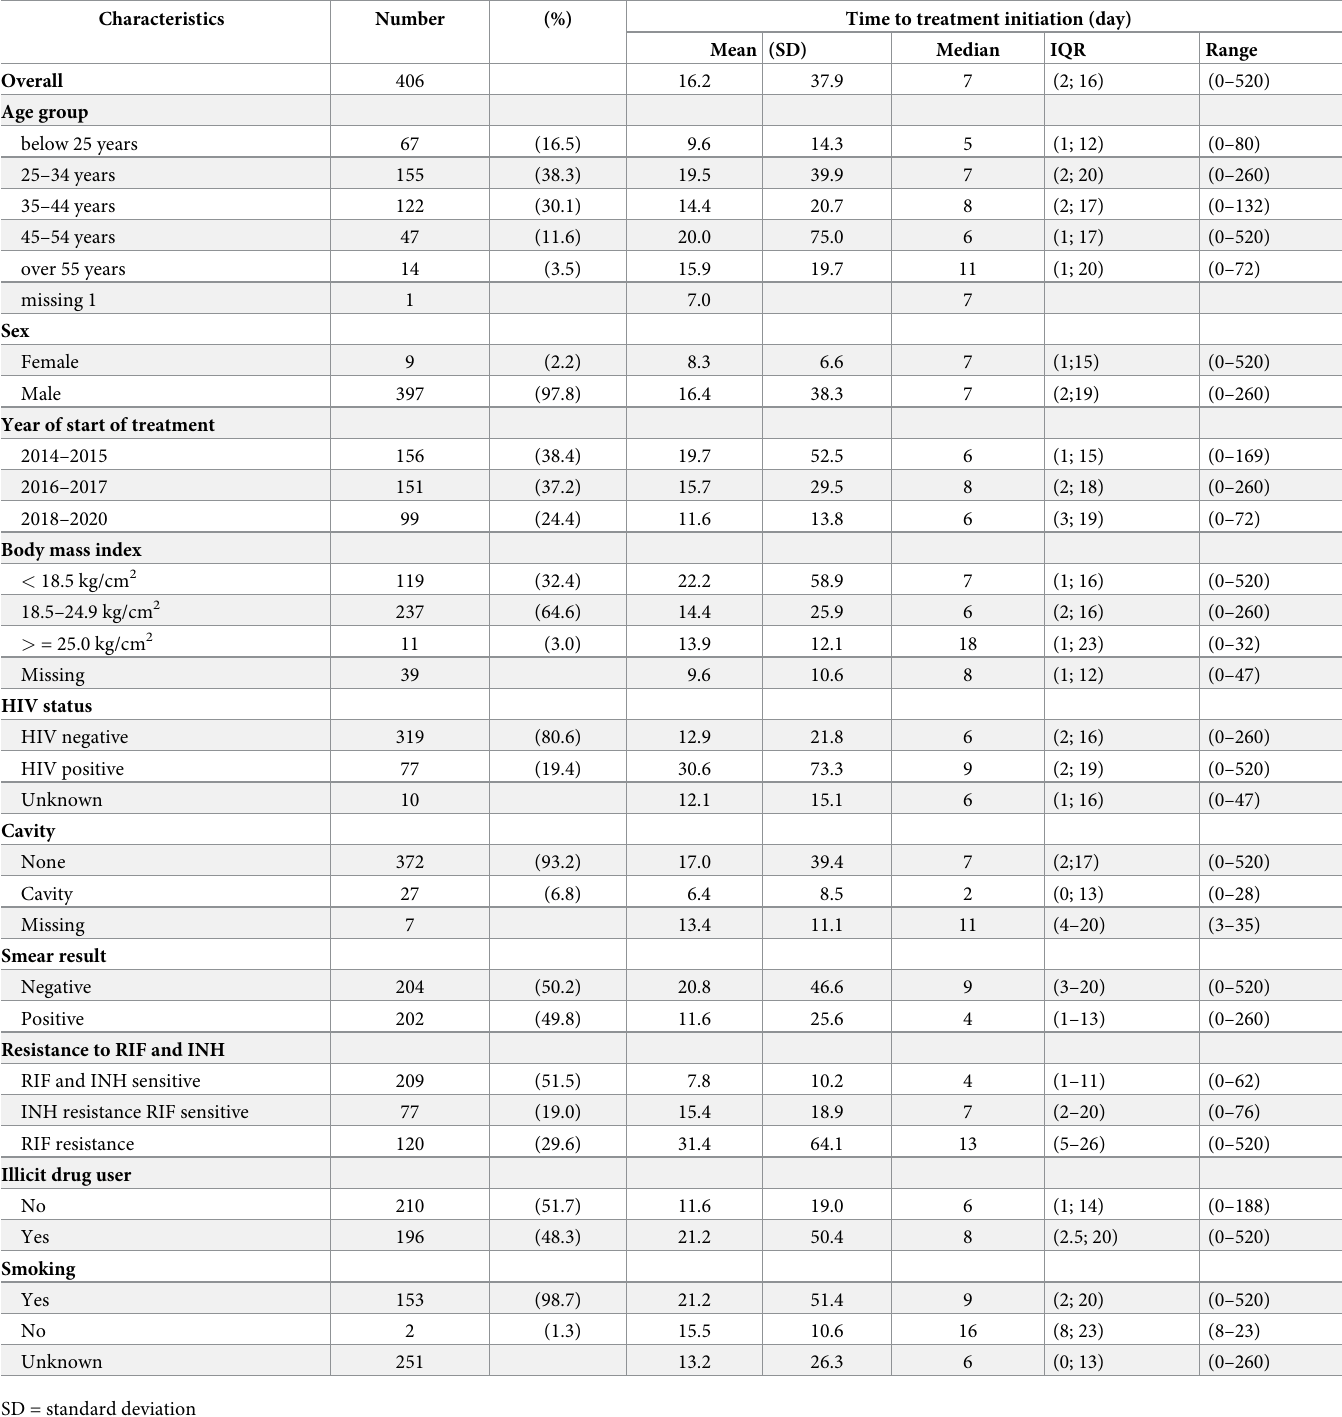
Table 1. Time (in days) from the date of specimen collection for microscopy or Xpert MTB/RIF) to TB treatment initiation by demographic and clinical